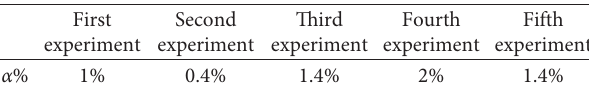
Table 4: Selection of de-singular value threshold α %.